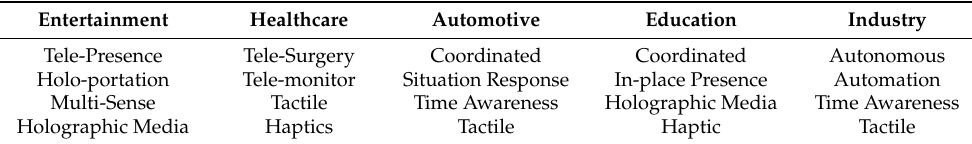
Table 2. Vertical Markets in 6G Network